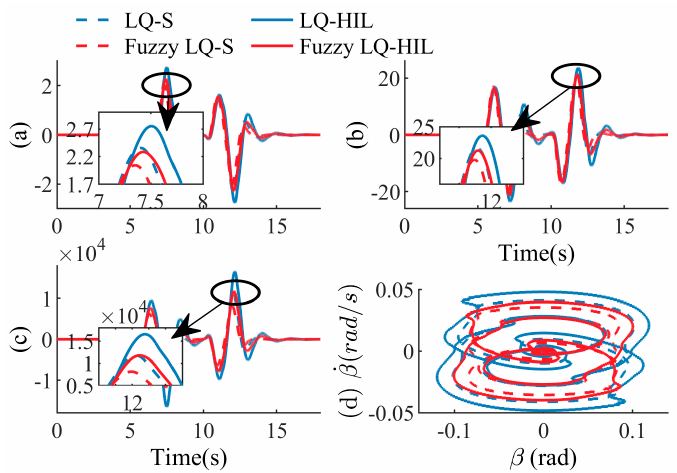
Figure 12. The control effect of single-line—change condition. ( a ) Roll angle (deg); ( b ) Yaw rate (deg/s); ( c ) Active yaw moment (Nm); ( d ) β β− phase diagram.